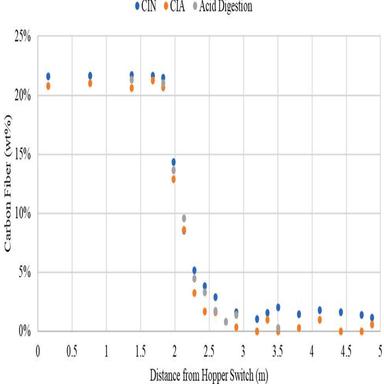
Characterization of the fiber content during the CF/ABS to ABS transition using CIN, CIA, and the developed UAAD methods.